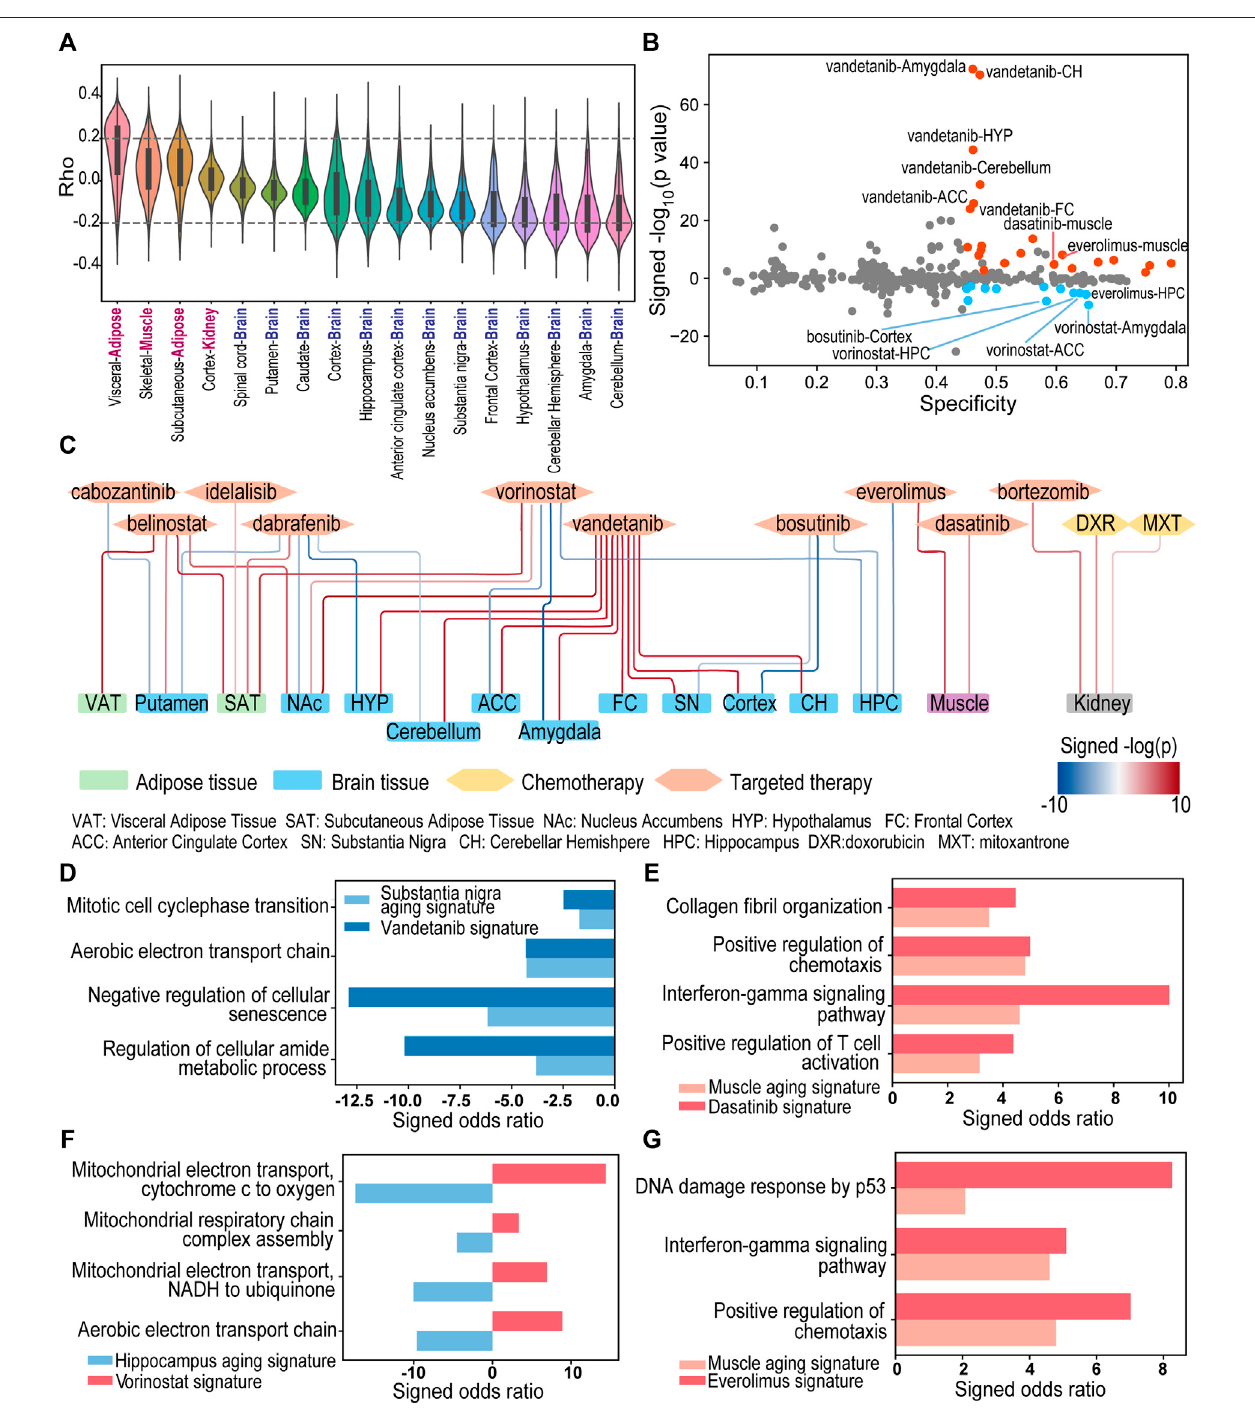
FIGURE 6 | The landscape of drug-aging interaction of 28 FDA approved drugs in brain, kidney, adipose, and muscle. (A) The distribution of the correlation between gene expression and the donor ’ s age in GTEx data. (B) The speci fi city (x-axis) and log-transformed p -values of the adjusted concordance ratio (y-axis) for the 326 interactions between drug-induced signatures and aging-associated signatures in multiple normal tissue types. A positive y-value represents CR > 1 and indicates aging-acceleratingeffect.Anegativey-valuerepresentsCR < 1andindicatesaging-protectiveeffect.Blue/Reddotsaresigni fi cantinteractionswithS > 0.45,CR < 0.9/CR > 1.1 and p < 0.01. (C) Network of 34 signi fi cant drug-aging interactions. Blue and red edges indicate protective and accelerating effects respectively. (D – G) Pathways enriched with overlapped genes between aging-associated signature and drug-induced signature. A positive/negative Enrichr odds ratio (red/blue bar) represents enrichment with up/downregulated genes.